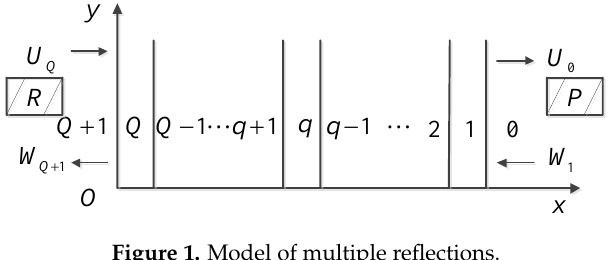
Figure 1. Model of multiple reflections.